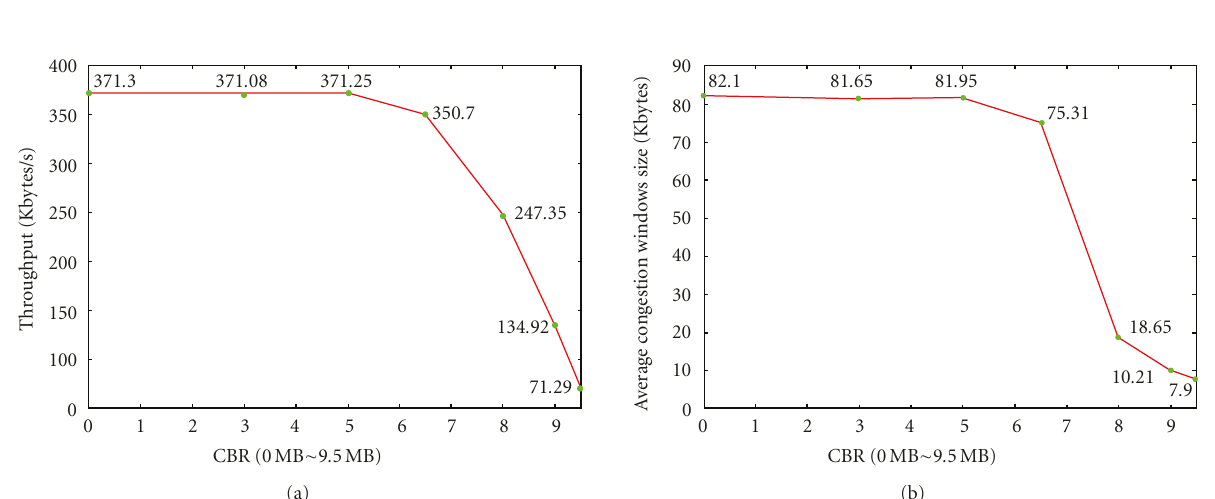
Figure 11: Impact of packet loss rate on transmission e ffi ciency.